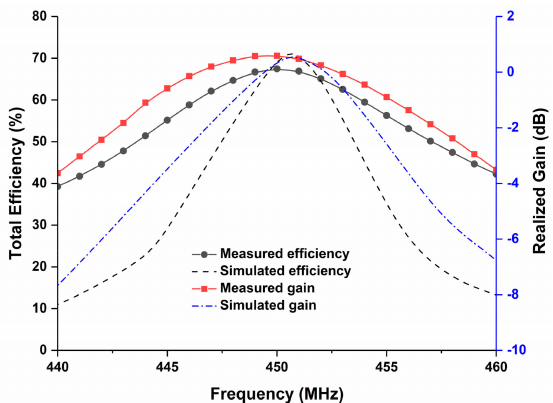
Figure 8. Measured radiation pattern at 450 MHz ( a ) azimuth and elevation ( b ) 3D pattern showing omnidirectional radiation characteristics.